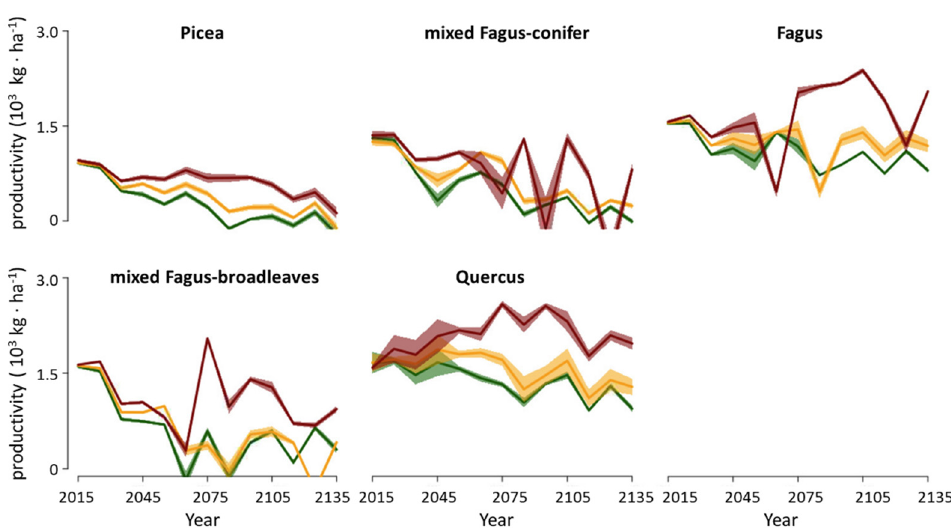
Figure 8. Productivity of the five main forest types ( Picea , Fagus –conifers, Fagus , Fagus –broadleaved, Quercus ) for the forecasts for every decade and climate change scenario: RCP 2.6 (green), RCP 4.5 (orange) and RCP 4.5 (red).